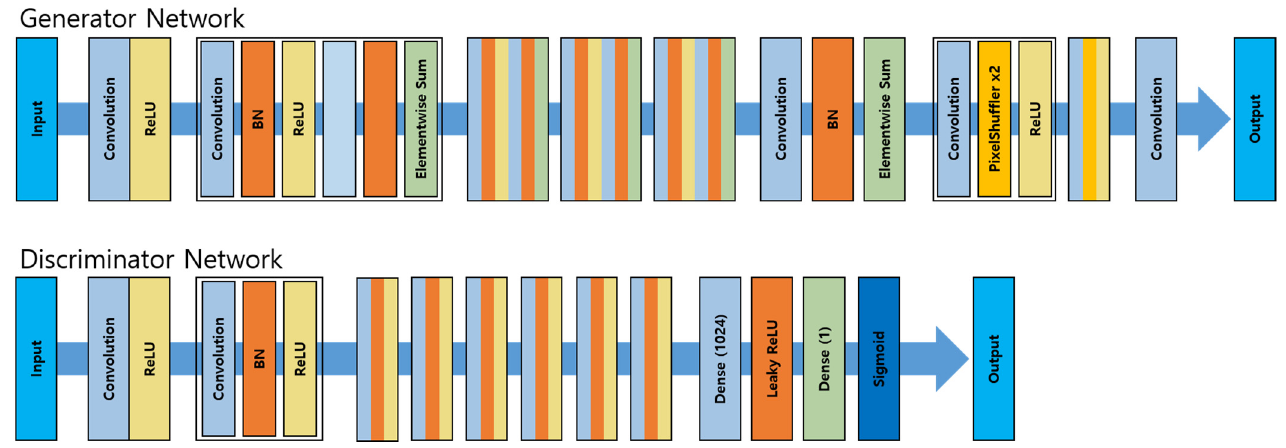
Figure 6. Diagram of the Generator and Discriminator Networks of SRGAN. The network process applies input data and analyzes inputted images pixel by pixel through convolution in order to extract the features of highly related pixels and apply them through the network. BN (Batch Normalization) enables learning in artificial neural networks by means of backpropagation. As the depth of the layer included in the artificial neural network increases, the gradient value transmitted by back propagation converges to 0 or diverges to achieve gradient vanishing or gradient exploding. Therefore, to improve overall learning speed, we used BN, a technique for reducing the frequency of occurrence of the problem by regularizing the values inputted to each layer, for SRGAN. Using the ReLU function, this was supplemented to prevent the loss of the gradient of the Deep Neural Network. By means of the method described, SRGAN learns one network with two networks connected. In the generator network, learning is carried out by comparing and analyzing the original image and the generated image. Additionally, this method removes the sigmoid from the network structure and calculates the loss function. After that, the final loss value is calculated using the calculated adversarial loss value and the content loss value. “Dense layer” refers to a layer that is combined with all neurons of the previous layer in the artificial neural network. Leaky ReLU is a modification of the ReLU function, and is a function that takes a negative number and reduces the value by 1/10. The following equation is the formula for the constructor (2) and the identifier (3) of SRGAN.